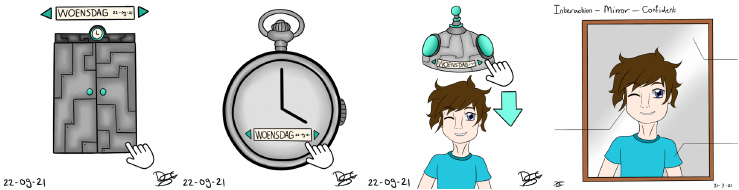
Figure 3. Different visualizations of the Time Travel concept. The student can choose when to interact with their future self by using the Time Travel feature. This can be visualized as a time machine, a clock, a time helmet or a future mirror. Pilot studies are needed to evaluate how students perceive these design